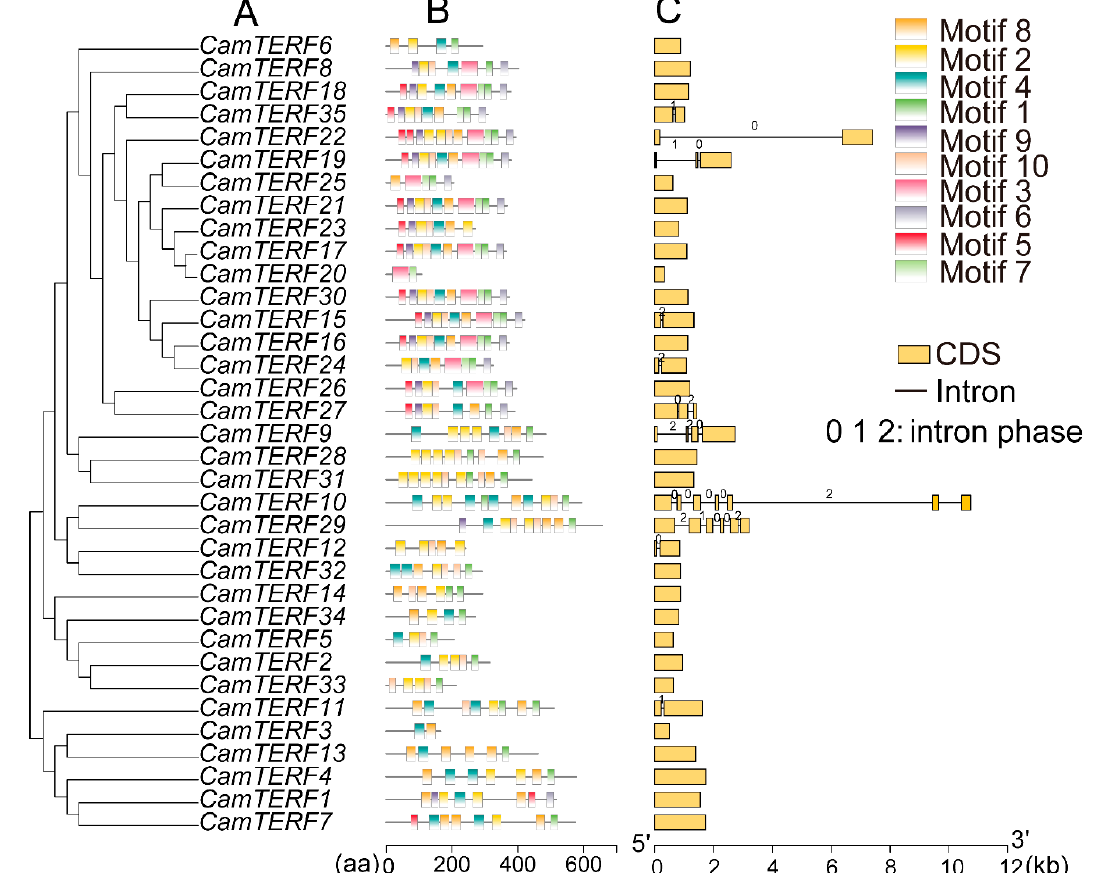
Figure 3. Phylogenetic relationship, conserved motif, and gene structure analysis of CamTERFs . ( A ) Phylogenetic tree of 35 CamTERFs . Depicted is an unrooted neighbor-joining phylogenetic tree; ( B ) Distributions of conserved motifs in CamTERFs . Ten putative motifs are indicated with di ff erent colored boxes. For details of motifs refer to Table 2; ( C ) Exon / intron organization in CamTERFs . Yellow boxes represent exons and black lines represent introns. The numbers 0, 1, and 2 represent the intron splicing phase. Exon length can be inferred by the scale at the